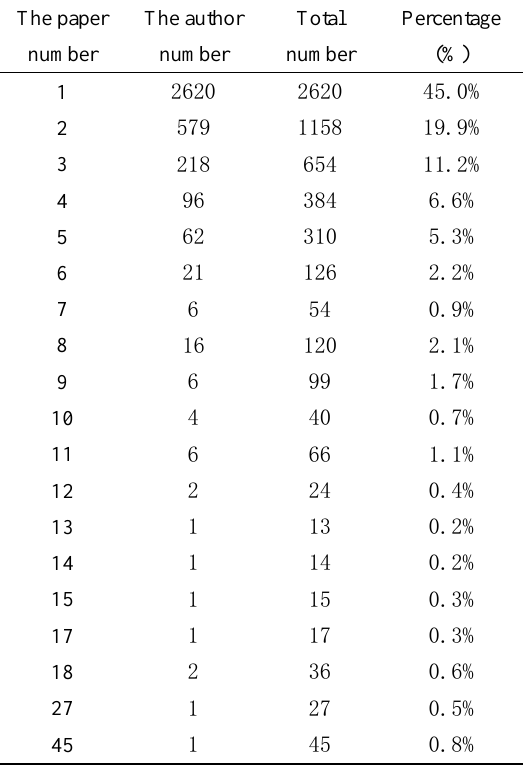
Fig.5 statistical data of author and the number of